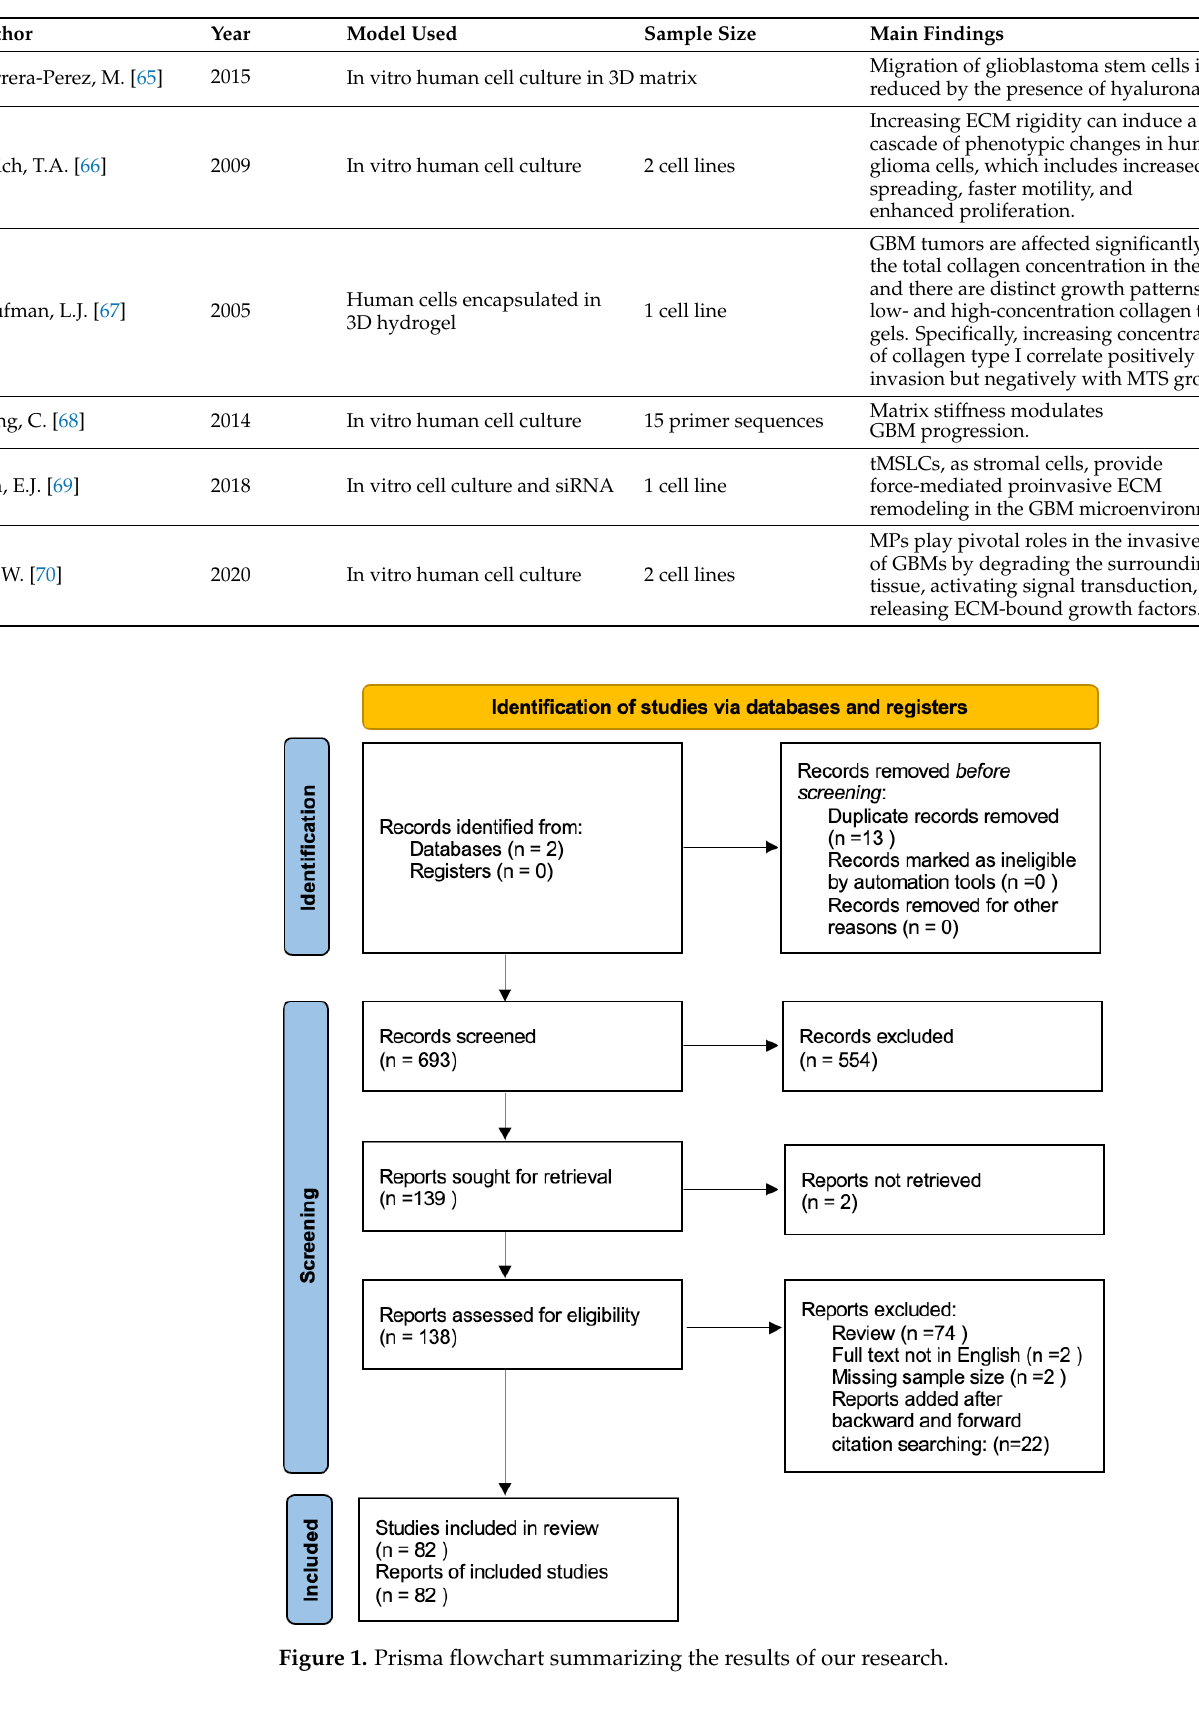
Table 6. Physical forces.